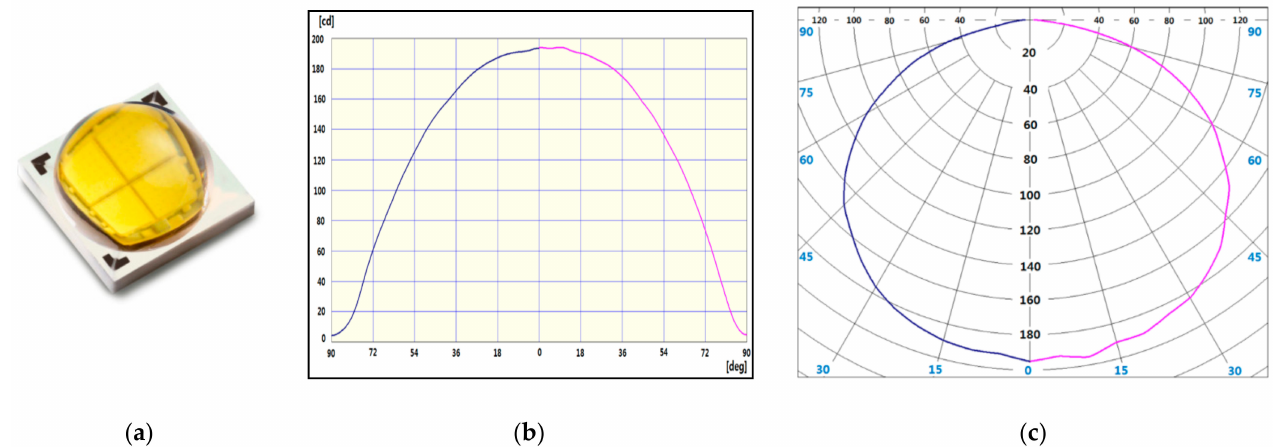
Figure 1. Photo of Lumileds’s Luxeon M LED PKG ( a ), measured viewing angle ( b ) and luminous distribution curve ( c ).